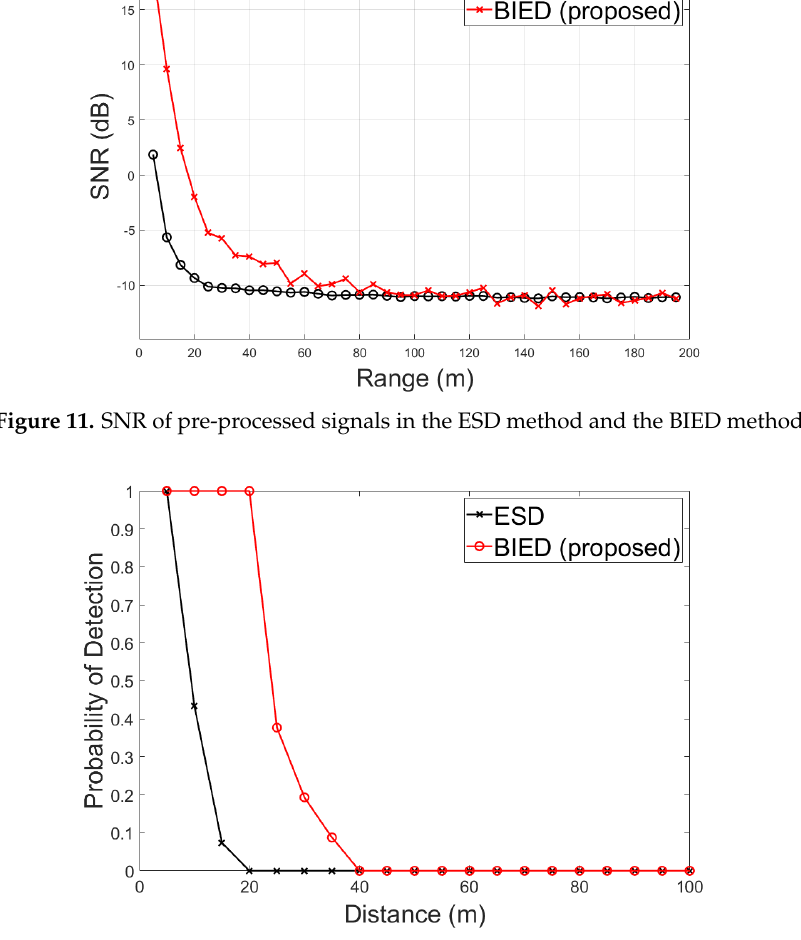
Figure 12. Detection probability. The detection threshold is set to T = D N env + D N env